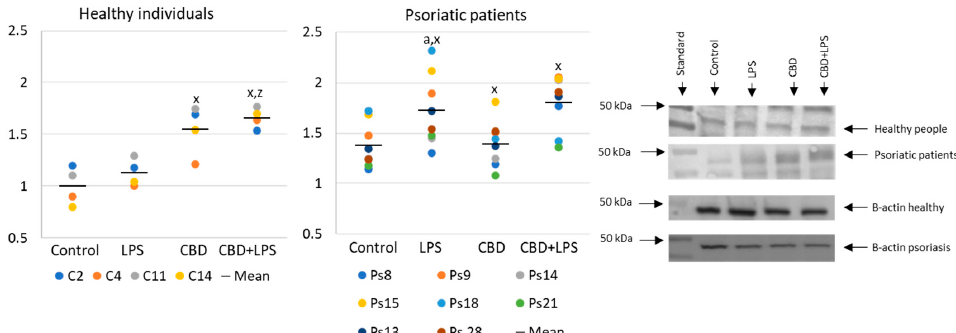
Figure 2. The level of p47 in neutrophils from heathy subjects ( n = 4) and psoriatic patients ( n = 8) after 1 h incubation with LPS, cannabidiol and LPS with cannabidiol. a—statistically significant difference between neutrophils from patients with psoriasis vulgaris and healthy subjects p < 0.05; x—statistically significant difference between treated neutrophils (with LPS, CBD, or LPS + CBD) and non-treated (control) cells; p < 0.05; z—statistically significant difference between neutrophils treated with LPS + CBD and treated only with LPS; p < 0.05.